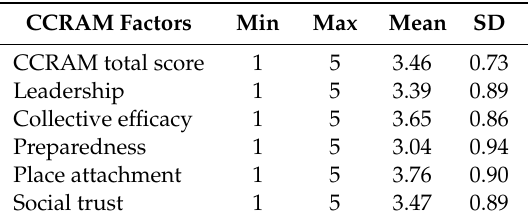
Table A2. Distribution of scores for individual CCRAM